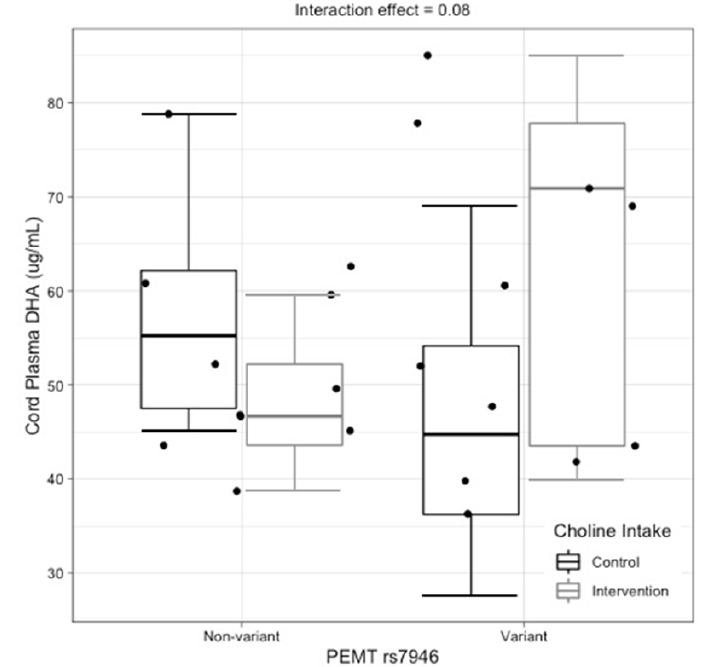
Figure 5. Interactive effects of newborn PEMT rs7946 genotype and choline intake on cord plasma- DHA ( μ g/mL) (raw data boxplot).